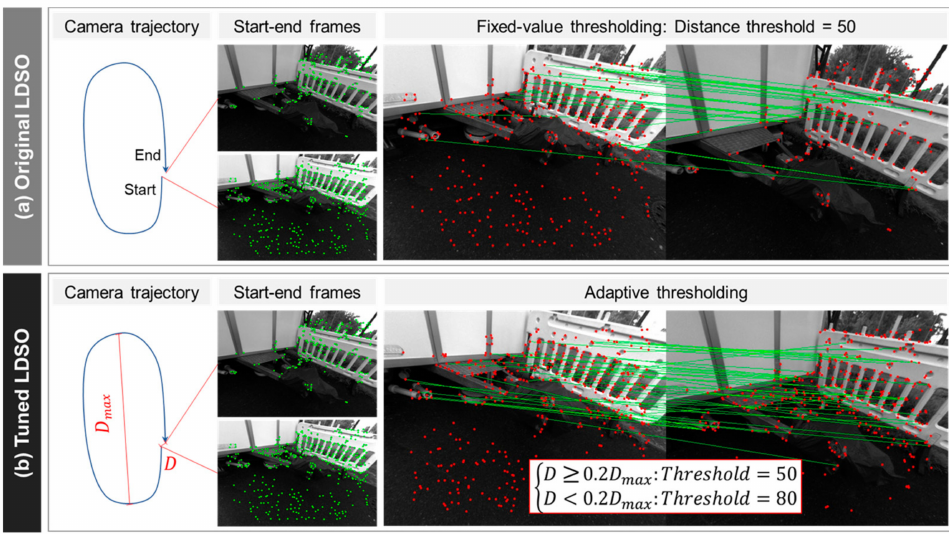
Figure 5. Loop closure module: ( a ) original LDSO and ( b ) tuned LDSO.